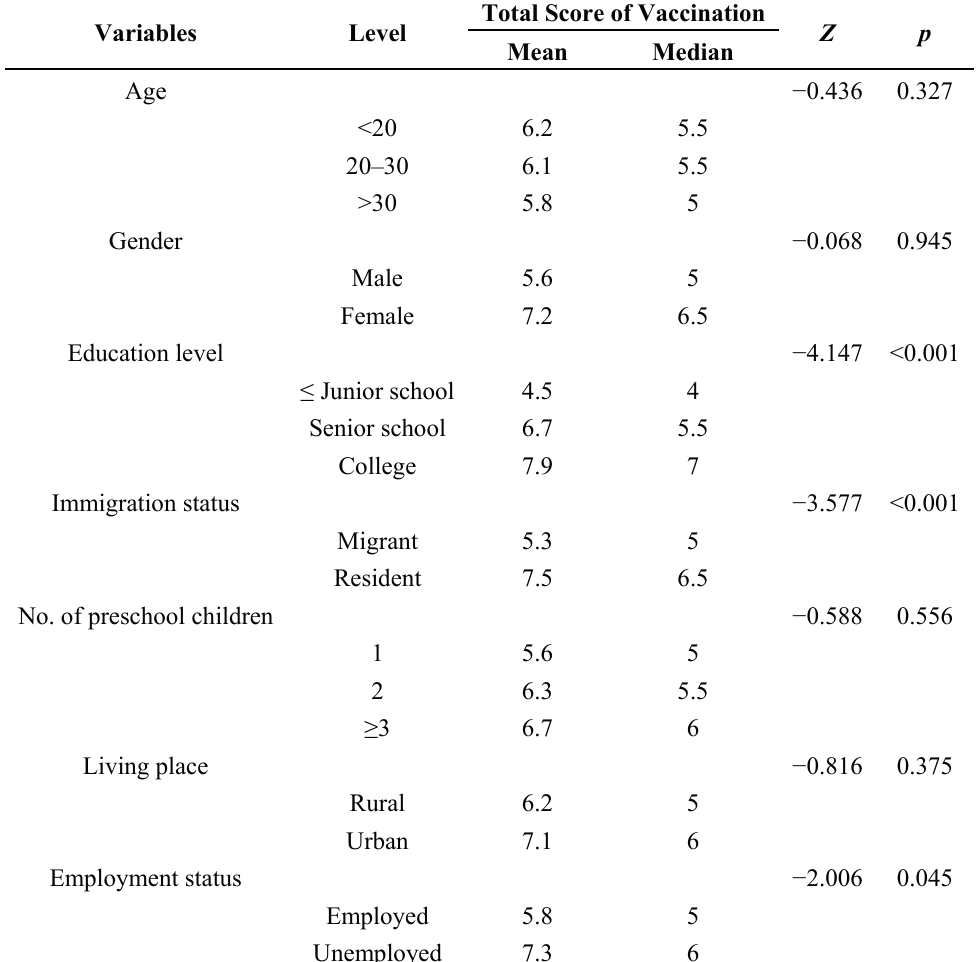
Table 4. Caregivers’ socio-demographic characteristics and their baseline total score of vaccination